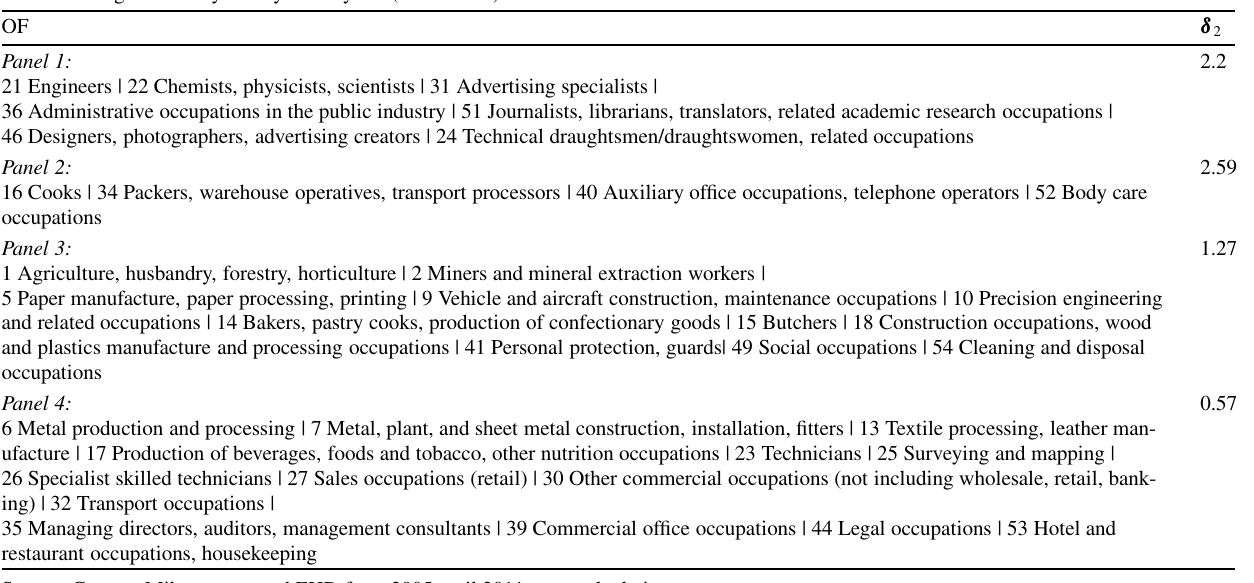
Table 2 Wage elasticitiy of stayers ı by OF (2005–2011) OF ı 2 Panel